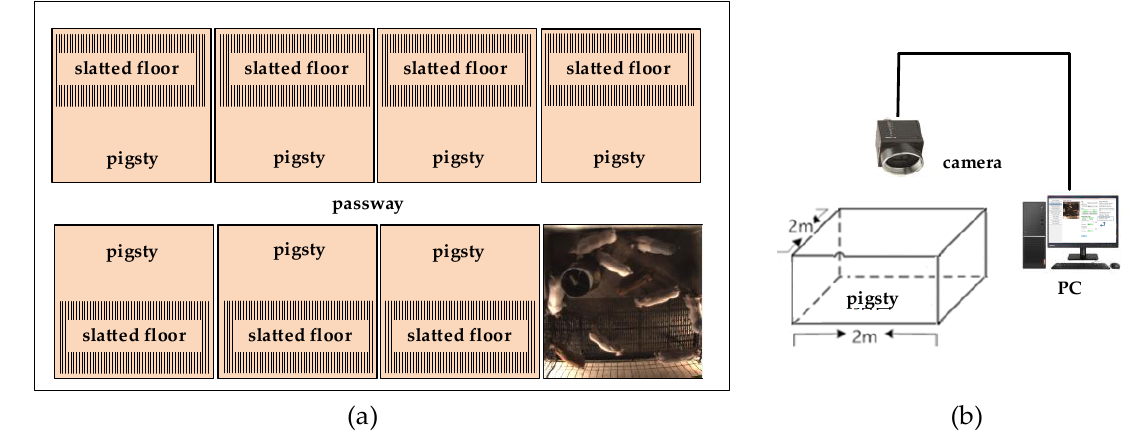
Figure 2. Pigsties and video capture platform. ( a ) Pigsties in the farm; ( b ) video capture platform.